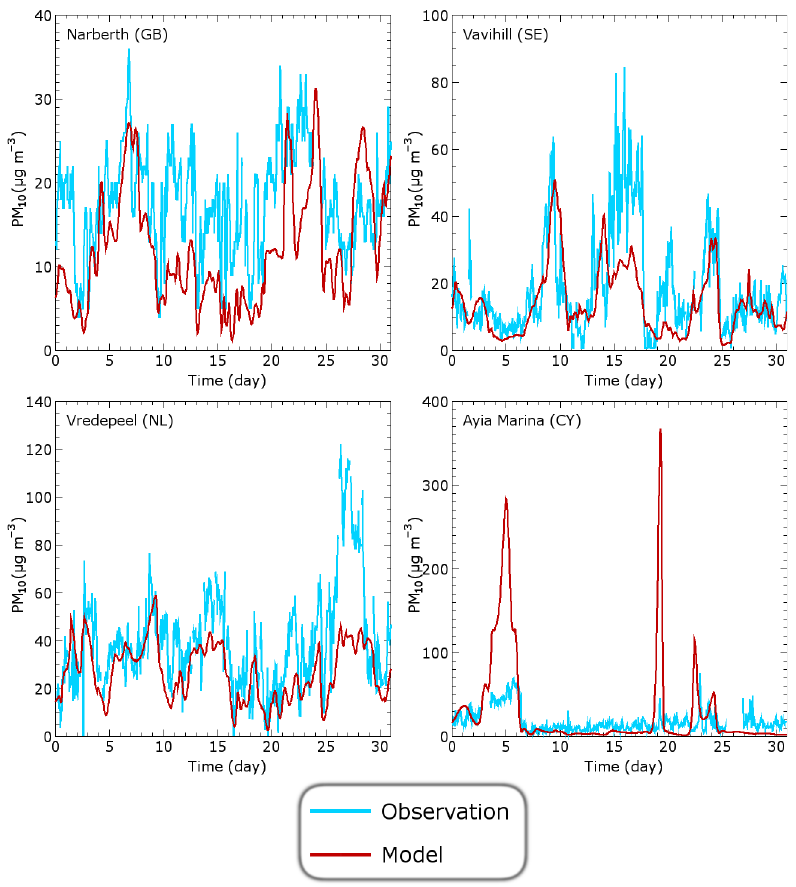
Fig. 5. Comparison between modelled and observed PM 10 concentrations in January 2006 for Narberth (GB), Vredepeel (NL), Vavihill (SE) and Ayia Marina